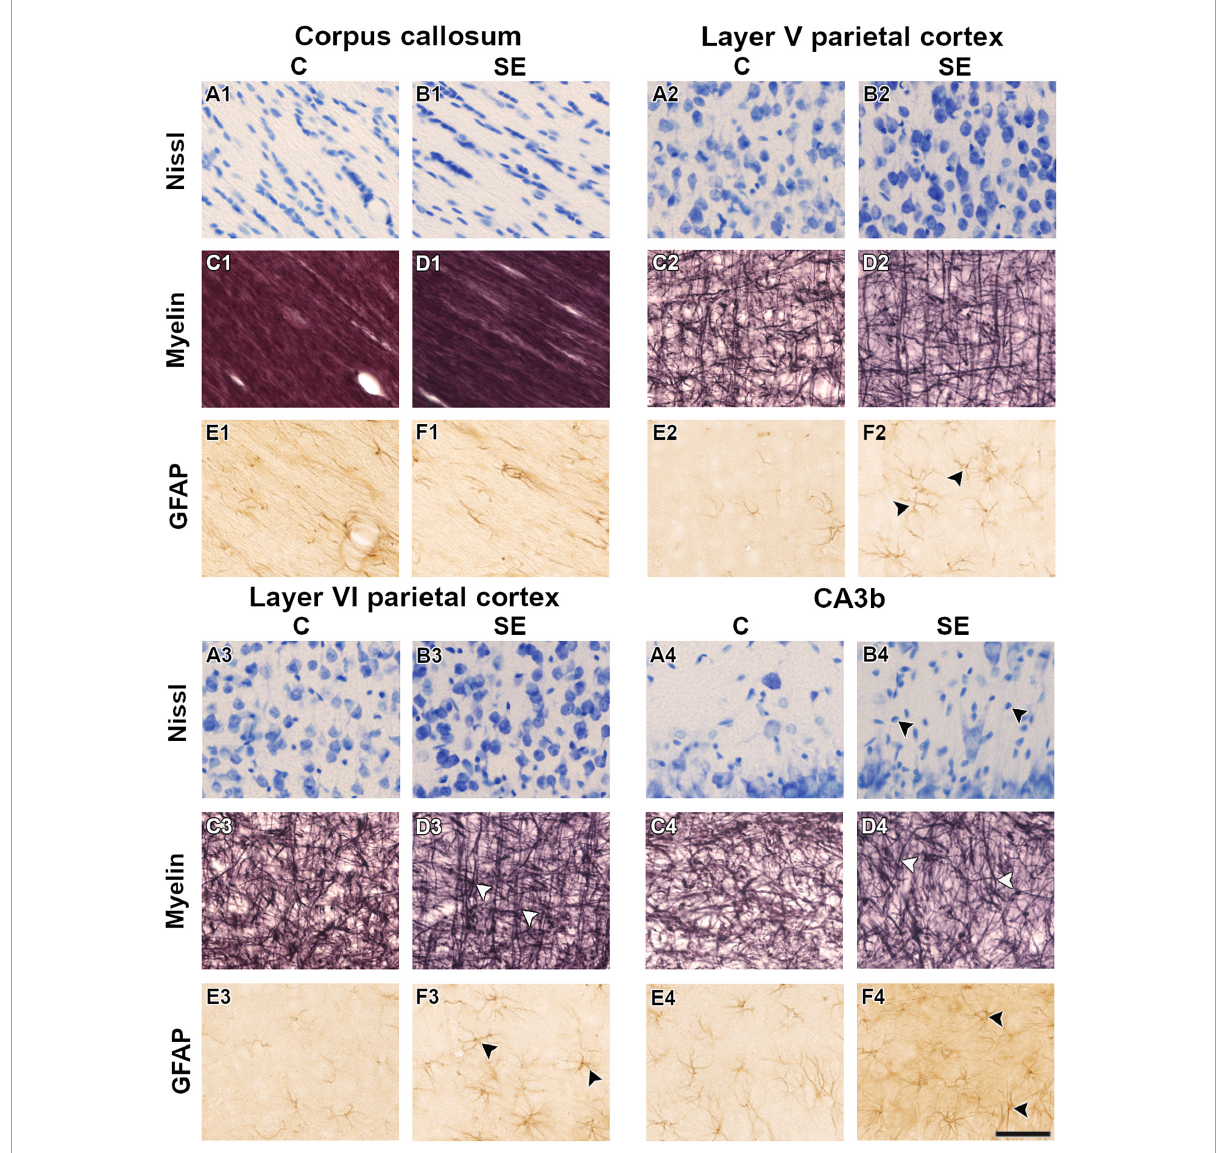
FIGURE3 Representative high-magnification photomicrographs in Nissl-, myelin-, and GFAP-stained sections of one control (A,C,E) and one status epilepticus (B,D,F) animal in white and gray matter areas. White arrowheads indicate changes in the organization of myelinated axons (D3,D4) . Black arrowheads indicate increased cellularity (B4) and an increase in the number of astrocyte processes and length (F2,F3,F4) at 79 days post-SE. The same animals are shown in the three stainings. Scale bar: 50 µ m. C, control; CA, cornus ammonis; GFAP, glial fibrillary acidic protein; SE, status